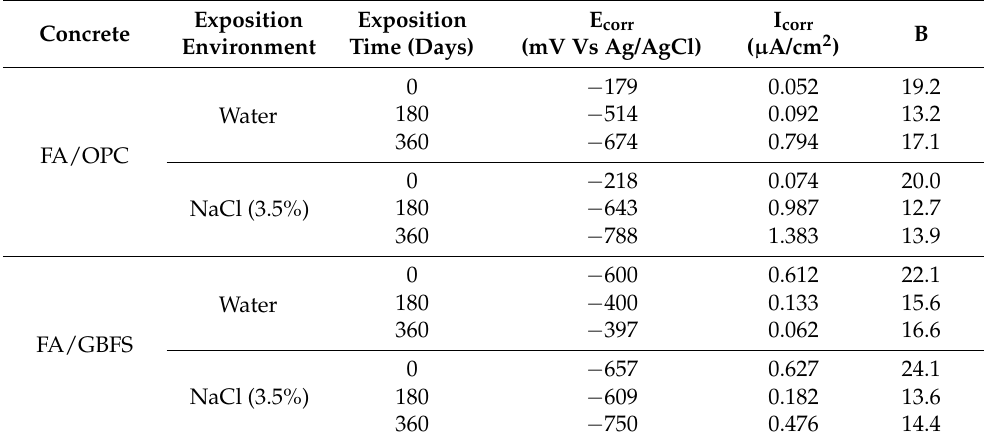
Table 5. Corrosion potential (E corr ), current density (I corr ) and constant of proportionality (B) of the reinforced